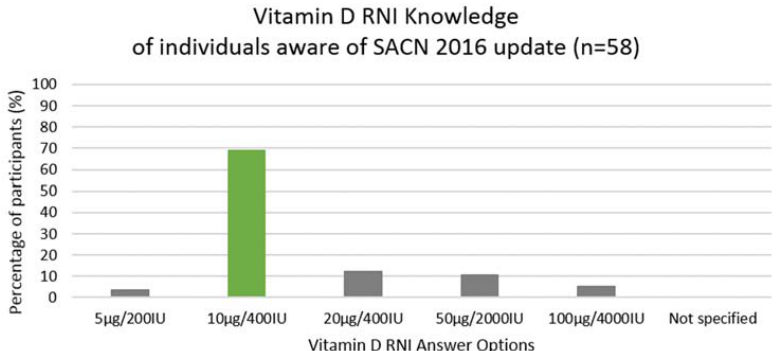
Figure 2. Vitamin D RNI knowledge of individuals aware of SACN 2016 guidelines . Participants’ (aware of the updated SACN 2016 vitamin D recommendations) knowledge on vitamin D RNI values ( n =